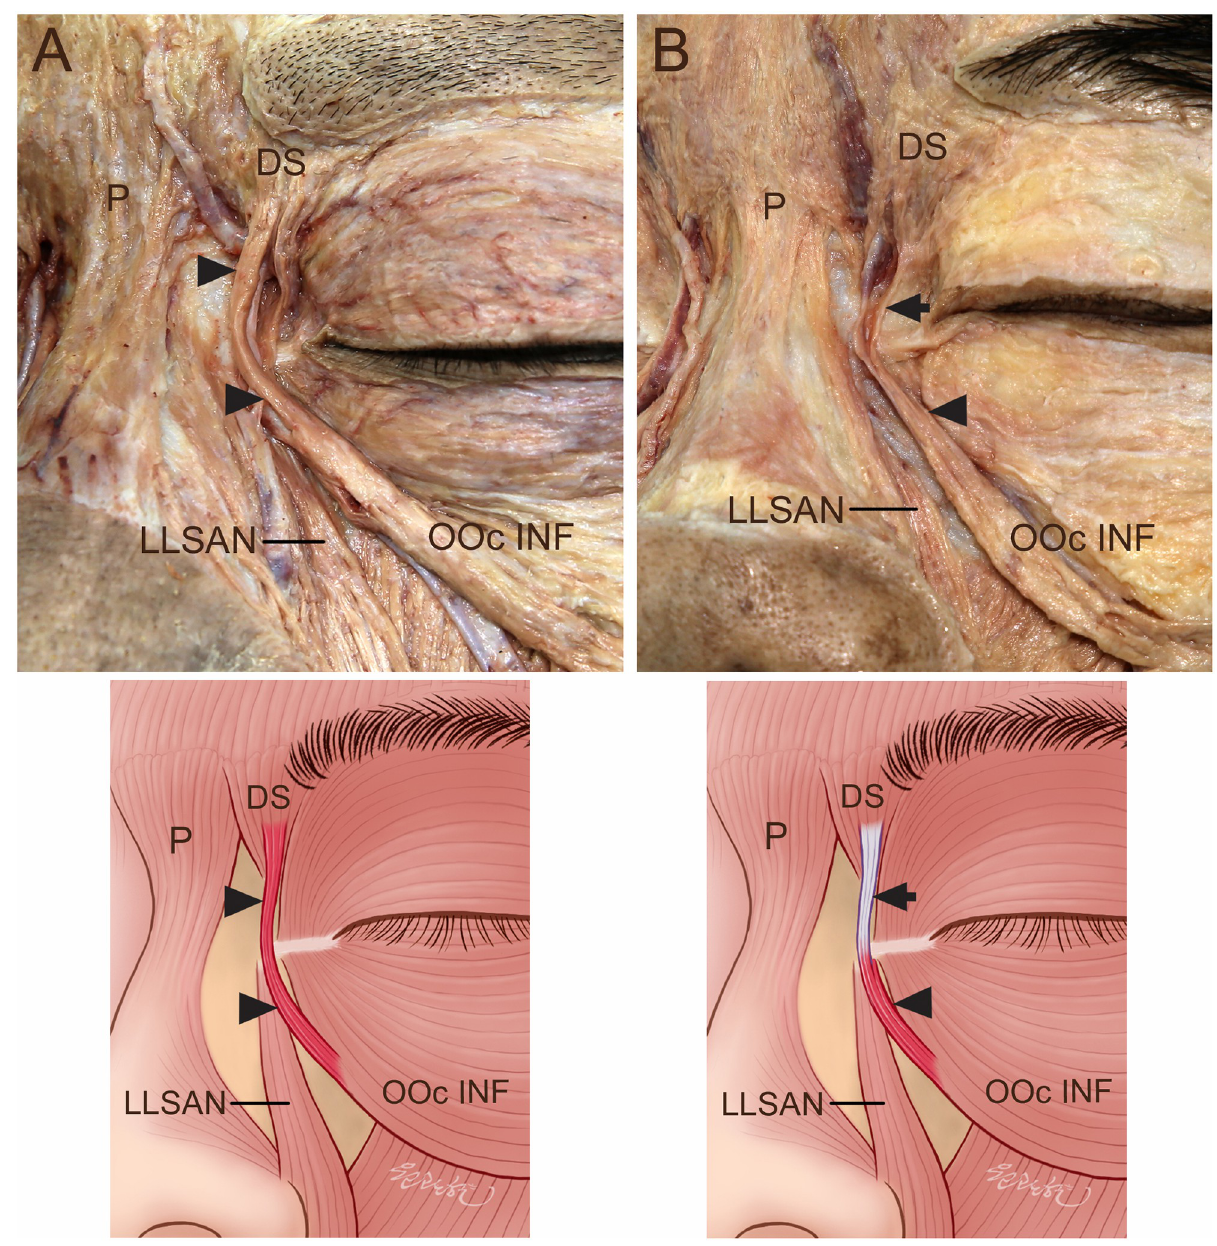
Fig 2. Connection of the DS to the OOc INF. (A) The DS was connected to the OOc INF by the muscle fibers (arrowheads). (B) The DS was connected to the OOc INF by the thin aponeurosis (arrows). Some muscle fibers (arrowheads) of the OOc INF were connected to the thin aponeurosis (arrows) coursing on the medial palpebral ligament, and the thin aponeurosis (arrows) of the OOc INF was connected to the DS.